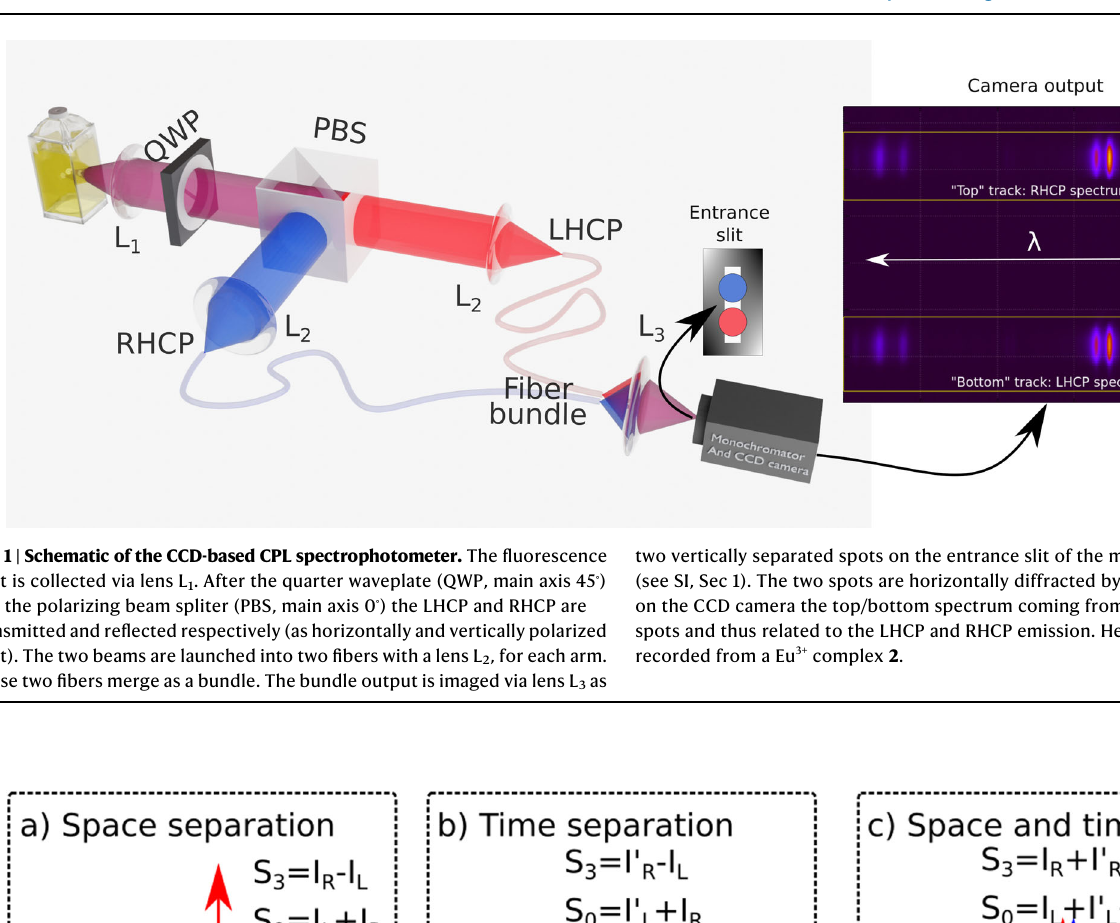
Fig. 2 | Threemeasurement con fi gurations to obtain CPL. Leftand right circular polarizations encoded spectraaremeasured: a simultaneously throughthetwoarms, b on the same arm after rotation of the QWP, and c as the sum of the two previous ones.